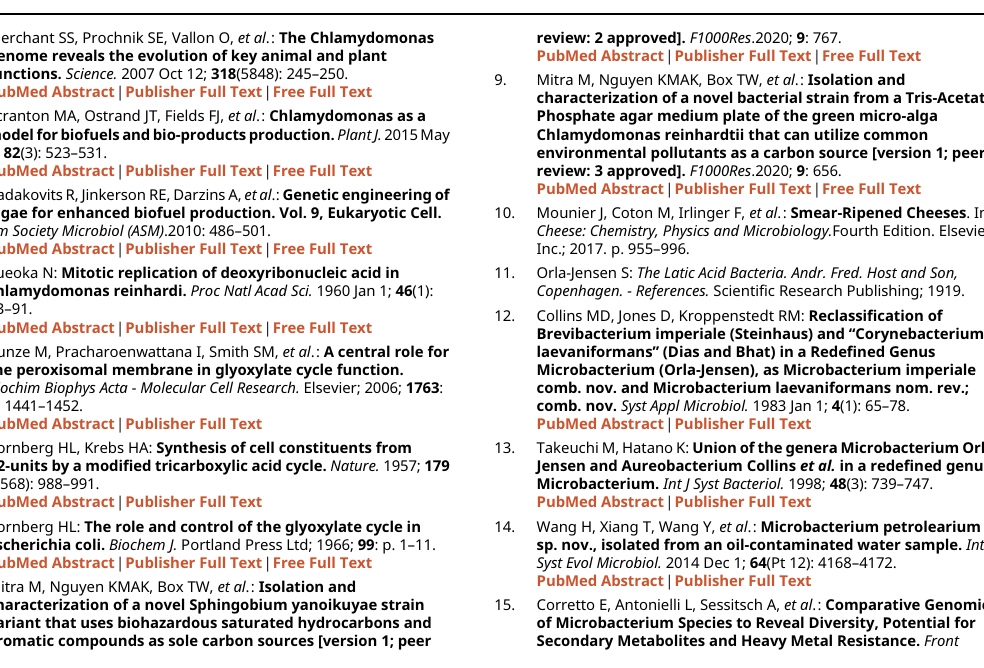
Figshare: Image of growth of Clip185/ Microbacterium binotii strain PK1-12M variant (Accession number: MN633284.1) on a LB plate containing 10 mM hexavalent Chromium (Cr 6+ ), https://doi.org/10.6084/m9.fig- share.14669421.